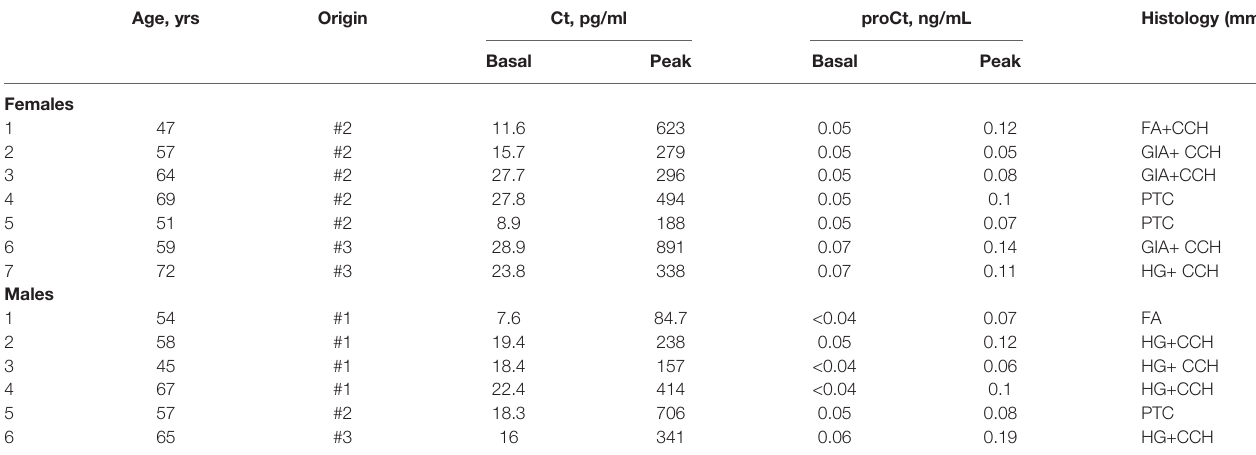
TABLE 4 | Clinical features of the patients submitted to calcium-stimulation test with a fi nal histological diagnosis negative for MTC. Age,